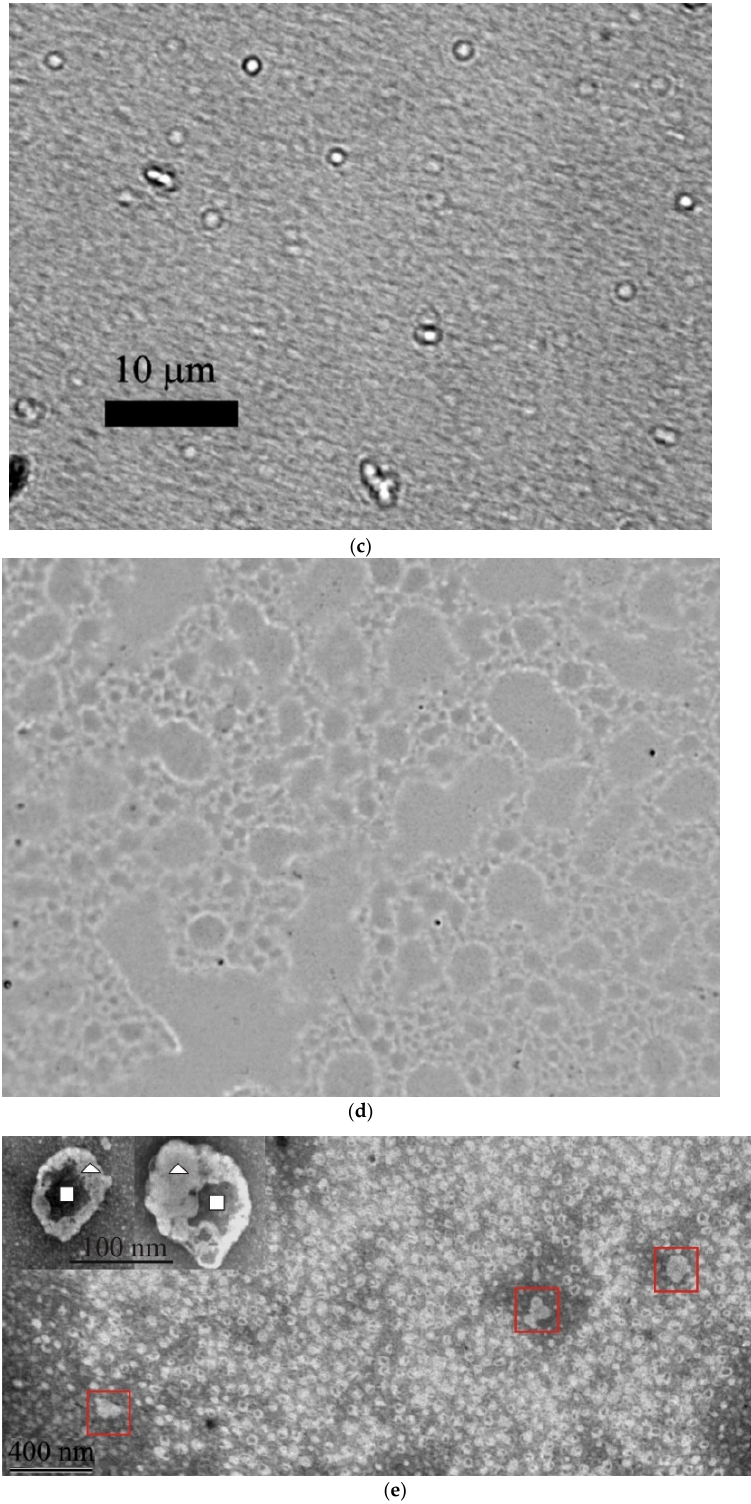
Figure 2. Physicochemical properties of MLPSICG: ( a ) particle size distribution with dynamic light scattering before (1) and after (2) sonication; ( b ) zeta potential distribution; ( c ) light microscopy im- age of “large” liposomes before sonication; ( d ) light microscopy microphotograph of dried “large” liposomes; ( e ) TEM image of MLPSICG. The agglomerated MLPSICG are labeled with red lined squares. The inset shows two enlarged individual liposomes containing magnetite nanoparticle(s) in the core (white squares) and lipid shell (white triangles). The average zeta potential of the MLPSICG in an aqueous medium as determined by ELS was − 51.35 mV (Figure 2b). This value points to good stability of the synthesized col- loid. Visual inspection of the colloid demonstrated excellent stability for 6 months at a